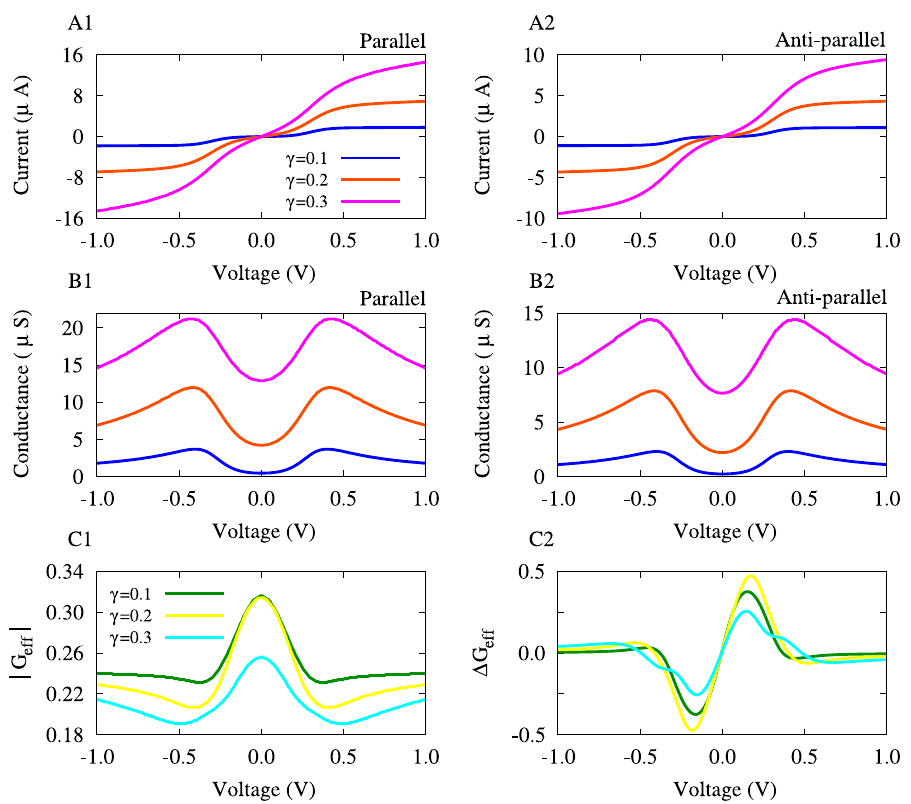
Fig 5. The effect of molecule-electrode coupling strength on the voltage-dependent plasticity of effective conductance in the PDT-based MTJ. ( A1,A2 ) Current-voltage characteristics in parallel (A1) and anti-parallel (A2) configurations for different values of the molecule-electrode coupling strength. ( B1,B2 ) The corresponding tunneling conductance derived from the spin-polarized current for parallel (B1) and anti-parallel (B2) states. ( C1 ) The effective tunneling conductance is calculated when the molecule-electrode coupling strength is varied. ( C2 ) The derivative of the effective conductance as a measure of its asymmetric change.